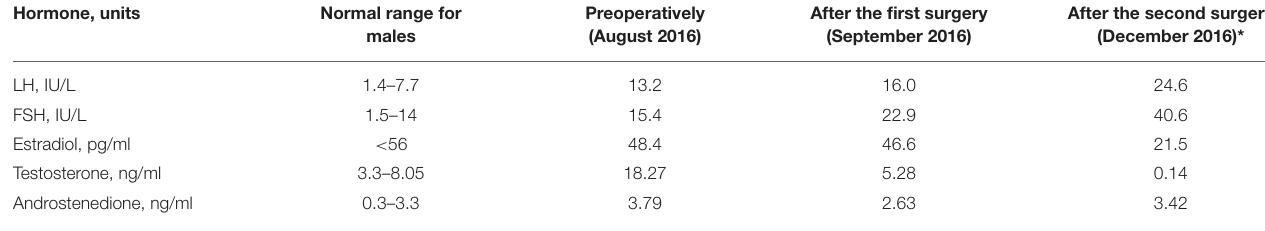
TABLE 1 | Preoperative and postoperative laboratory blood tests in the patient. Hormone, units